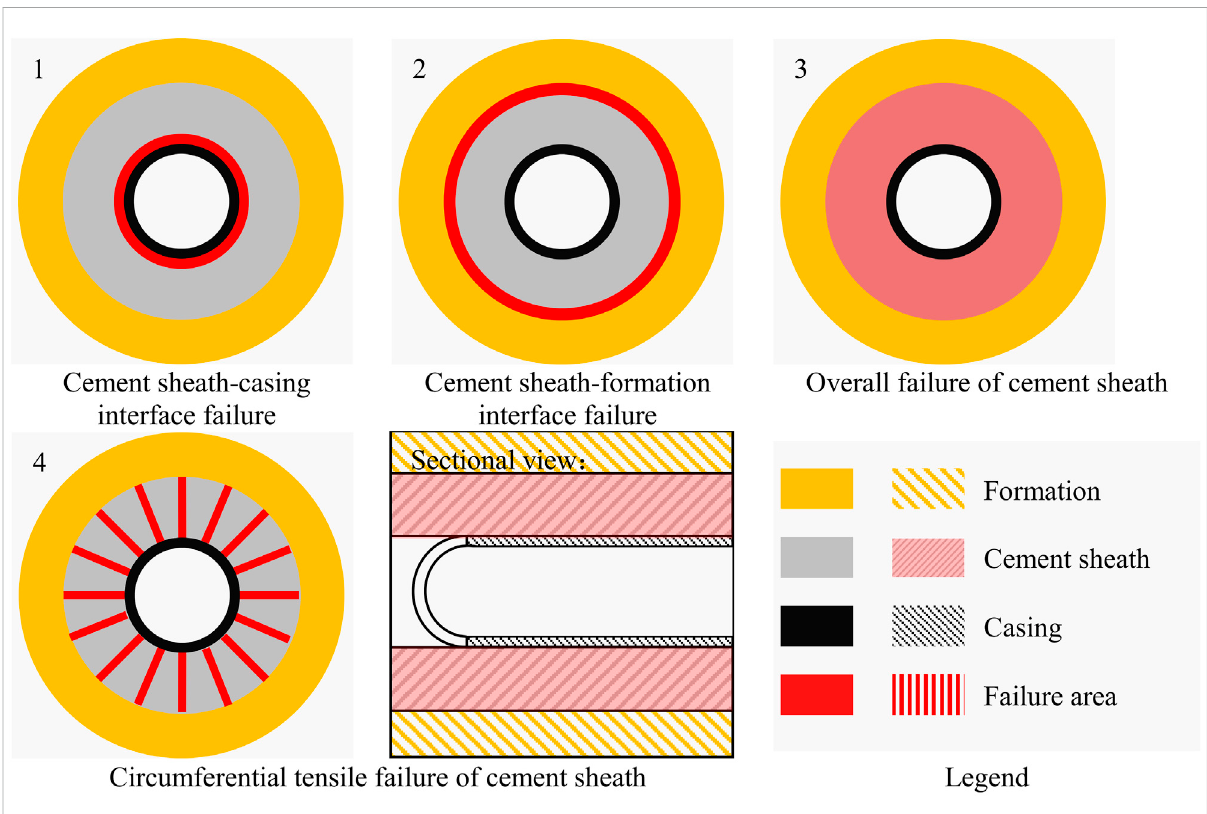
FIGURE 1 Schematic diagram of cement sheath seal integrity